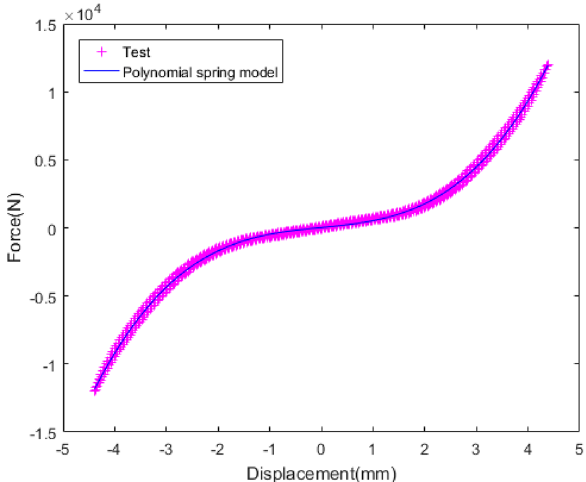
Figure 18. Fitting curve of static stiffness.